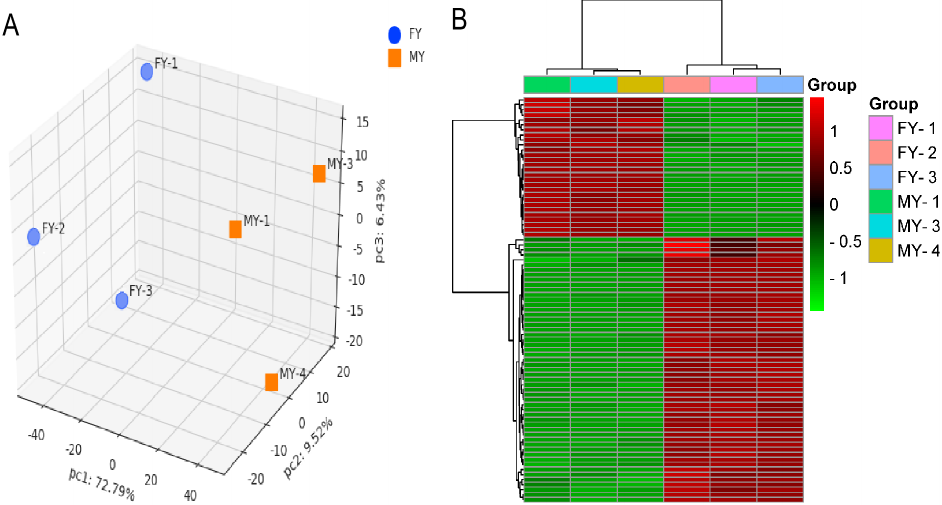
Figure 1. ( A ) Principal component analysis (PCA) of the subcutaneous fat in female (FYs) and male yaks (MYs); ( B ) Hierarchical clustering analysis of the proteome profiles in FYs and MYs subcutaneous fat. Red and green indicate higher and lower expression values, respectively. Table 3. Crucial differentially expressed proteins (DEPs) involved in unsaturated fatty acid (UFAs) metabolism in yak subcutaneous fat.